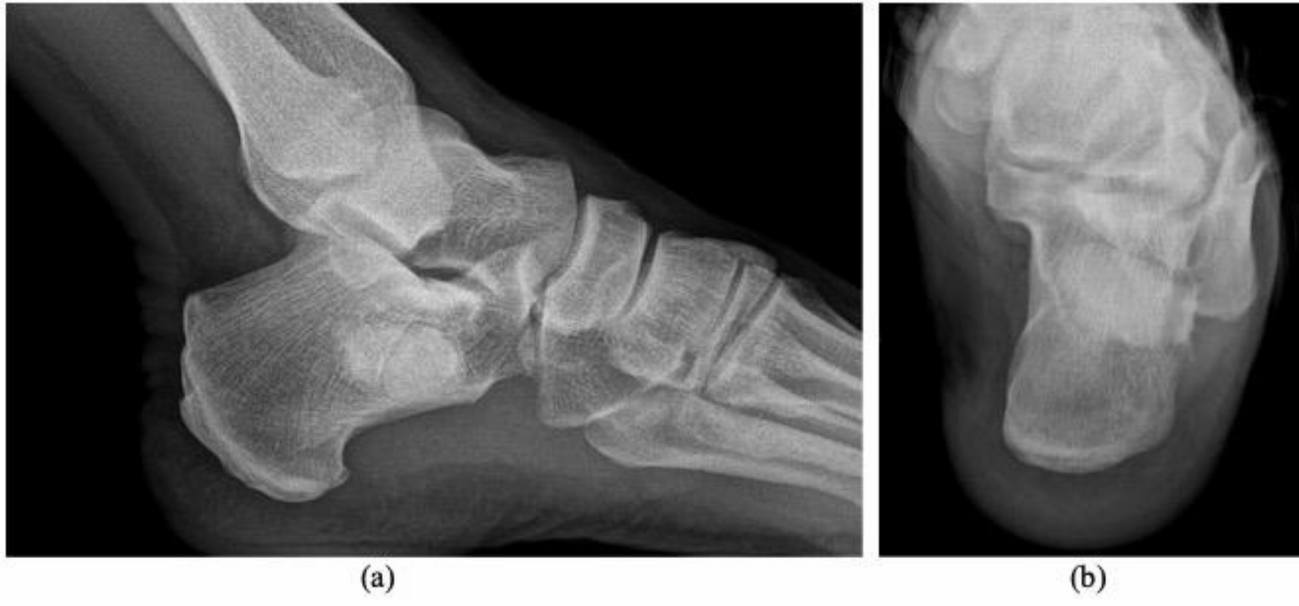
Figure 5. Calcaneum AP ( a ) and axial ( b ) Radiographs show a two years follow-up result of an intraosseous lipoma that underwent curettage and cement filling. No sign of local recurrence is